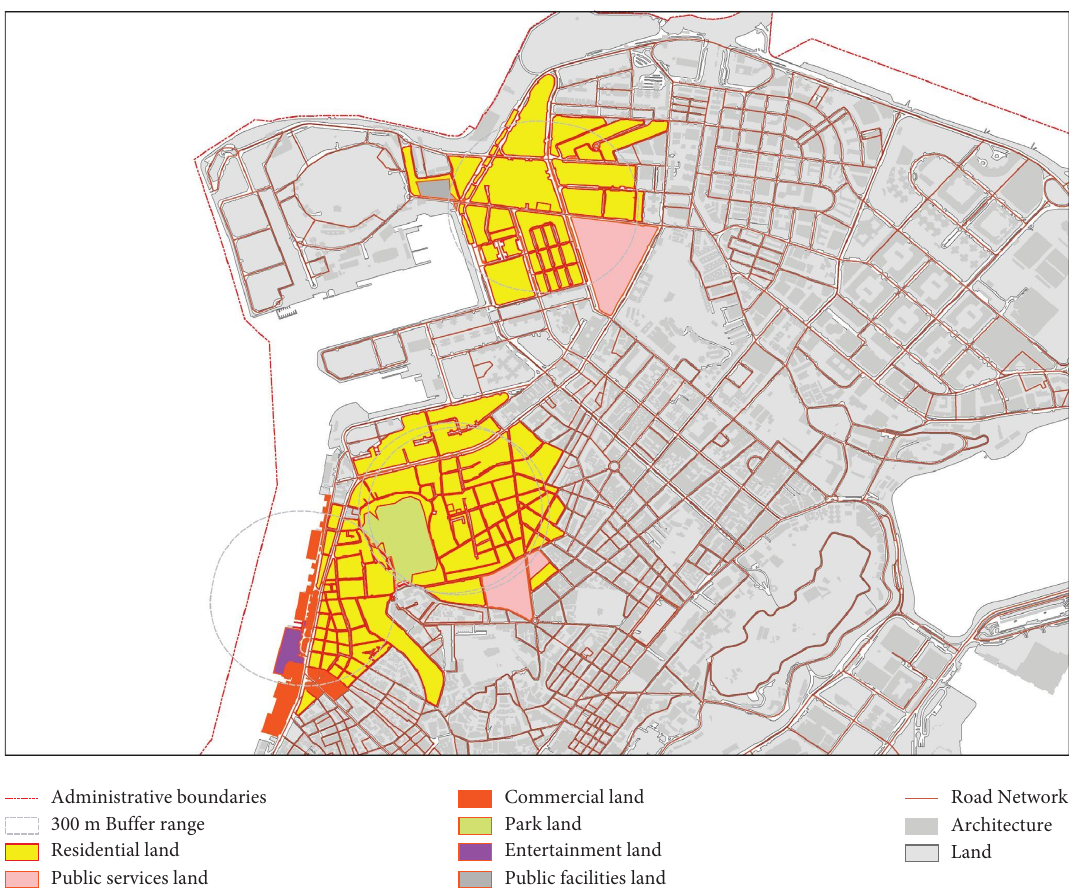
Figure 5: Assessment of the spatial diversity of urban renewal in Macau (source: self-drawn by the